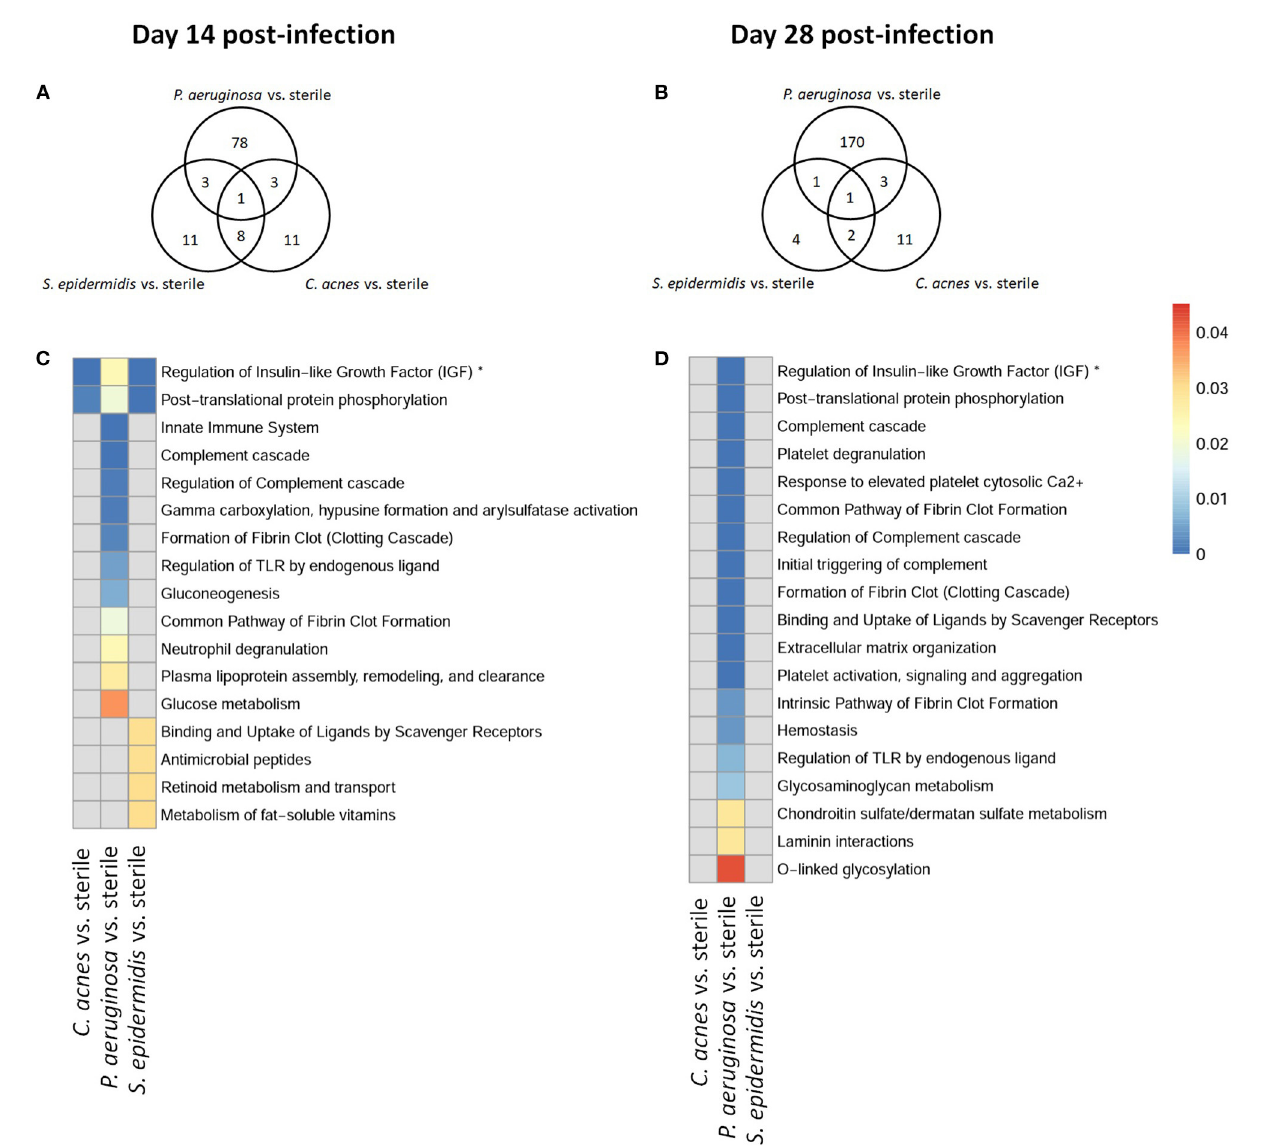
FIGURE3 Quantity of differentially expressed proteins in P. aeruginosa , C. acnes , and S. epidermidis infection and overlap between infection types at intermediate time points, day 14 (A) and 28 (B) post-infection as well as functional enrichment at day 14 (C) and 28 (D) post-infection. *Represents abbreviation of regulation of Insulin-like Growth Factor (IGF) transport and uptake by Insulin-like Growth Factor Binding Proteins